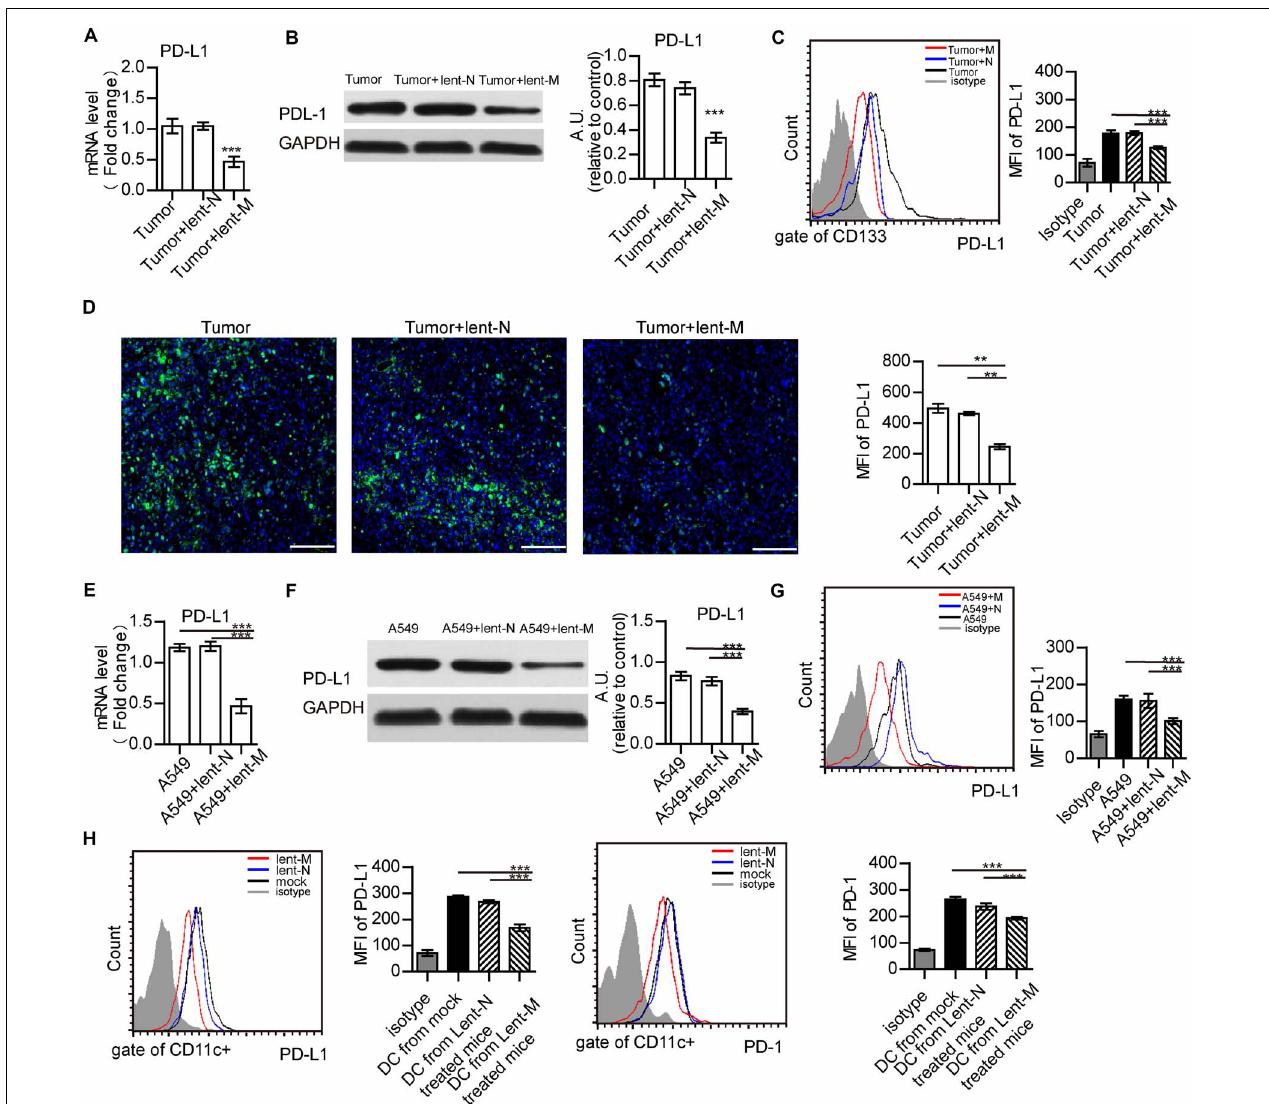
FIGURE 4 | MiR-138 treatment results in decreased expression of PD-L1 in tumor cells. (A) The gene expression levels of PD-L1 in tumors from lent-miR-138 (lent-M) treated mice were lower than those of the lent-NC (lent-N) treatment and untreated groups. (B) PD-L1 protein expression levels in tumors from microRNA-138 treated mice were lower than those of the NC treatment and untreated groups. (C) Flow cytometry analyzed showed that the level of PD-L1 expression on the CD133 + tumor cells from lent-M treated mice was lower than those of the lent-N treatment and untreated groups. (D) Immunofluorescence showed that the level of PD-L1 expression on tumors from lent-M treated mice was lower than those with lent-N treatment and untreated groups. Bar = 100 µ m (** P < 0.01). (E,F) After miR-138 treatment, the gene and protein levels of PD-L1 were decreased in A549 cells. A549 cells were transfected with miR-138 mimic lentivirus (lent-M) or the corresponding negative control (lent-N). Twenty-four hours after lentiviral transfection, RT-qPCR (E) or Western-blot (F) was performed to examine the gene expression levels of miR-138 in A549 cells (*** P < 0.001). (G) Flow cytometry analyzed showed that the expression of PD-L1 on the surface